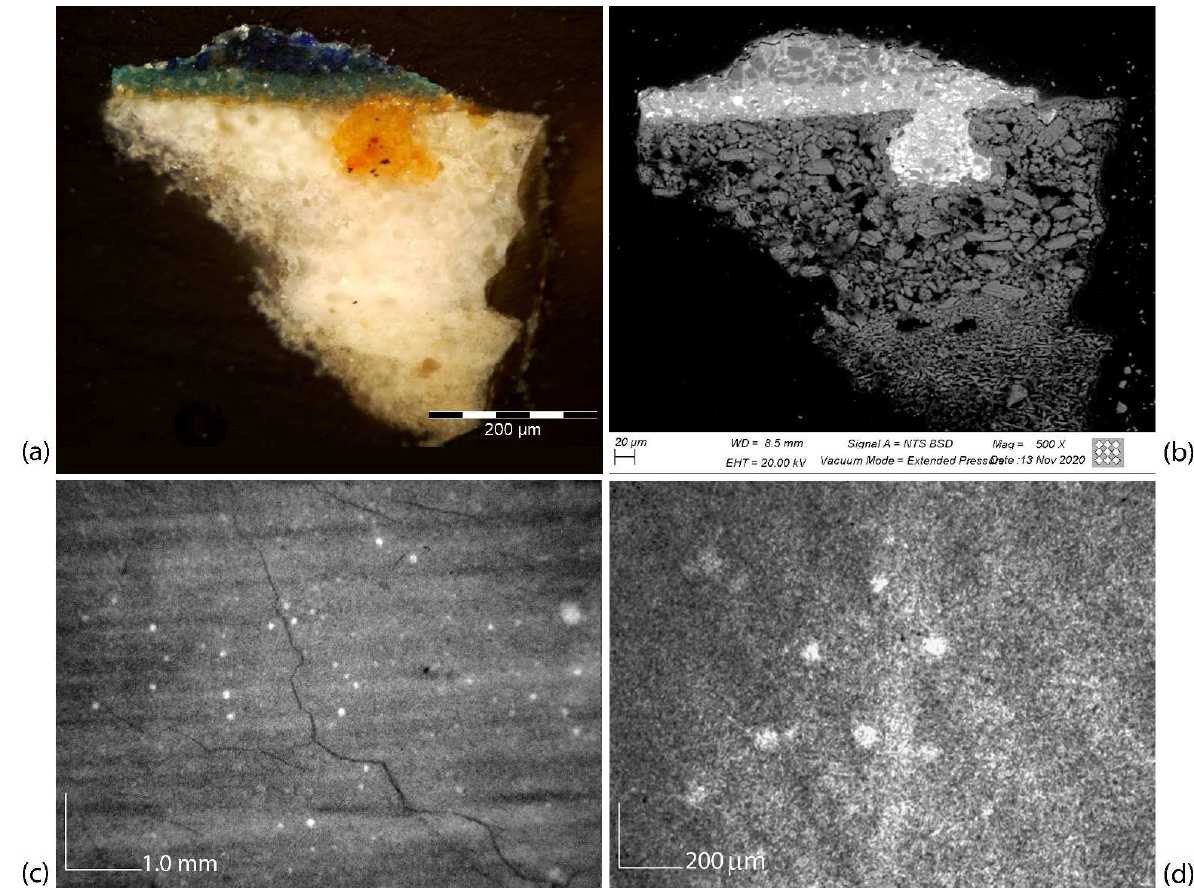
Figure 9. Microscopic images of a cross section of the Virgin’s blue mantle sample in OM ( a ) and SEM/BSE ( b ), showing a yellow-orange rounded inclusion of pigmented imprimitura in the plaster preparation. Above this, two pictorial layers—the first in azurite, the second in lapis lazuli—render the color of the blue mantle. The size of the imprimitura inclusions in the plaster is fully compatible with the enlarged radiographic details at 55 × ( c ) and 220 × ( d